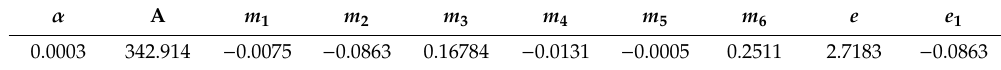
Figure 12. Flow chart of establishing the modified Hensel–Spittel (mHS) equation. Table 4. Material parameters in the modified Hensel–Spittel (mHS)